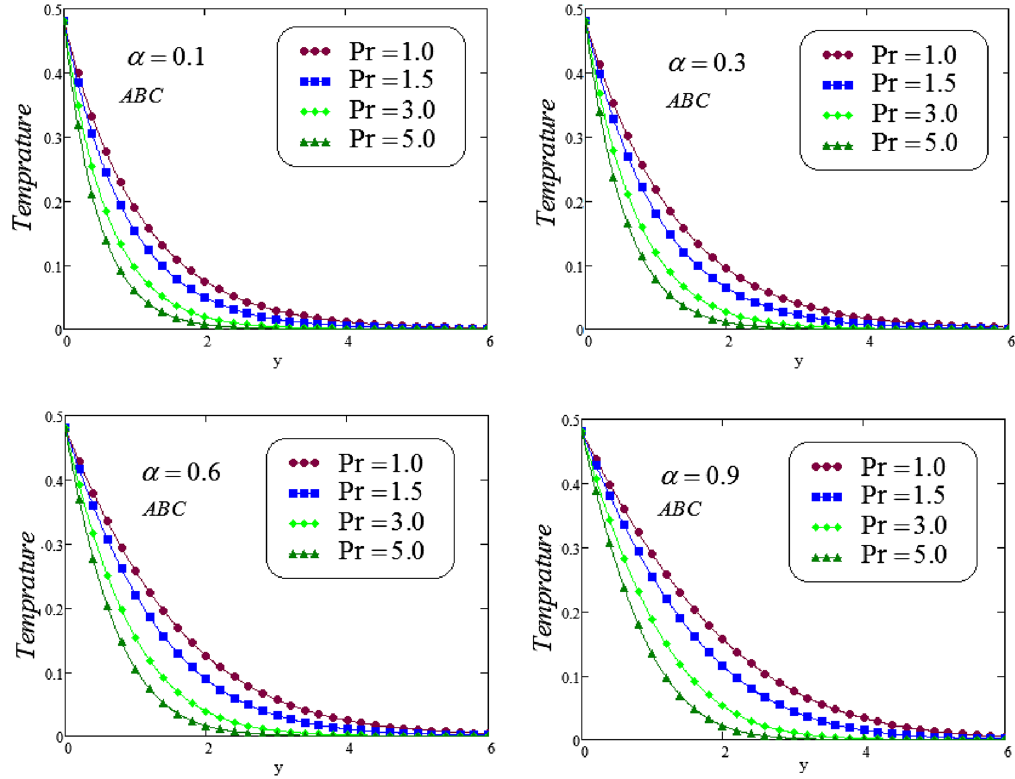
Figure 3. Simulation to illustrate the temperature profile for varying the values of Pr via ABC at distinct values of the fractional parameter α .